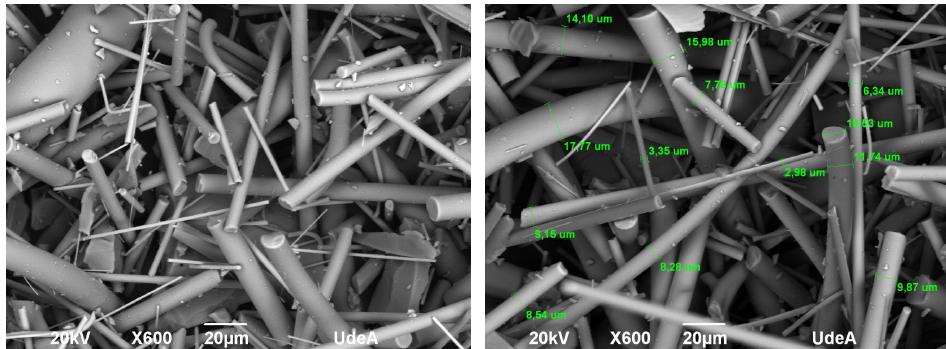
Figure 4. SEM images of the stone wool fiber after the grinding process.